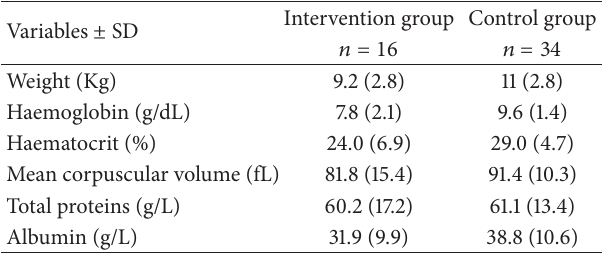
Table 3: Differential (delta) of weight and biological parameters in the study population.